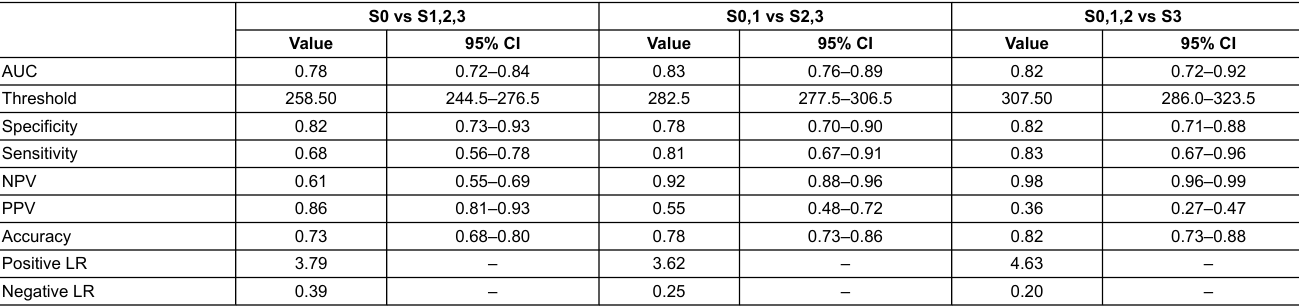
Table 3: Performance of CAP on the basis of the area under receiver operating characteristics curves